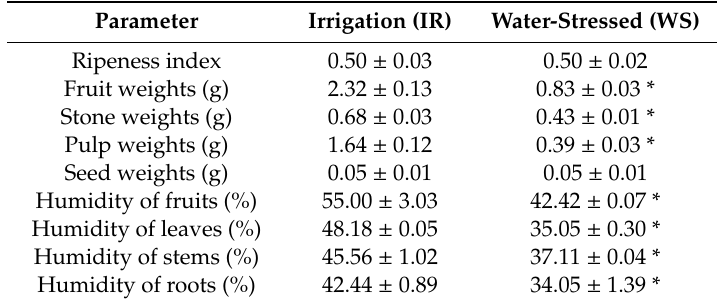
Table 1. Ripeness index, fresh weights and humidity of the organs of olive tree growth under irrigation or rain-fed conditions.